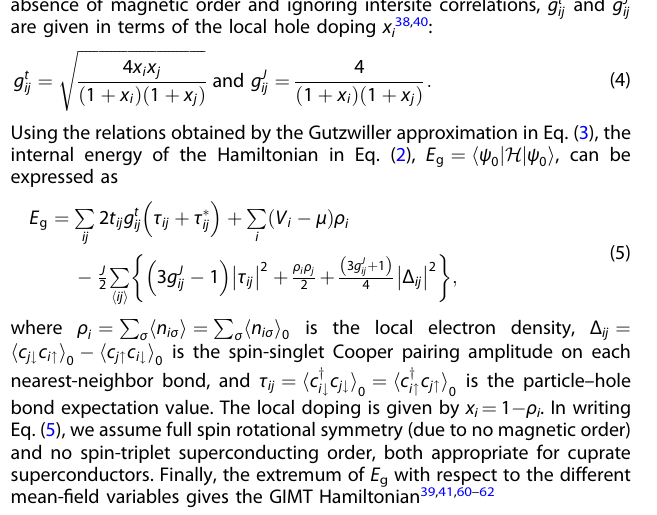
ffiffiffiffiffiffiffiffiffiffiffiffiffiffiffiffiffiffiffiffiffiffiffiffiffiffiffiffiffiffiffi 4 x i x